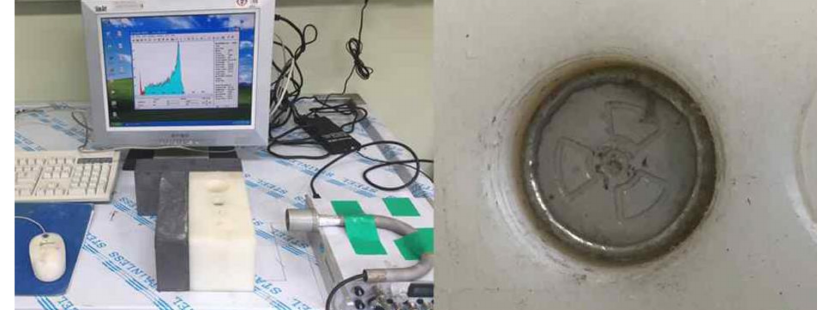
Figure 3. Experimental setup for thermal neutron shielding performance.